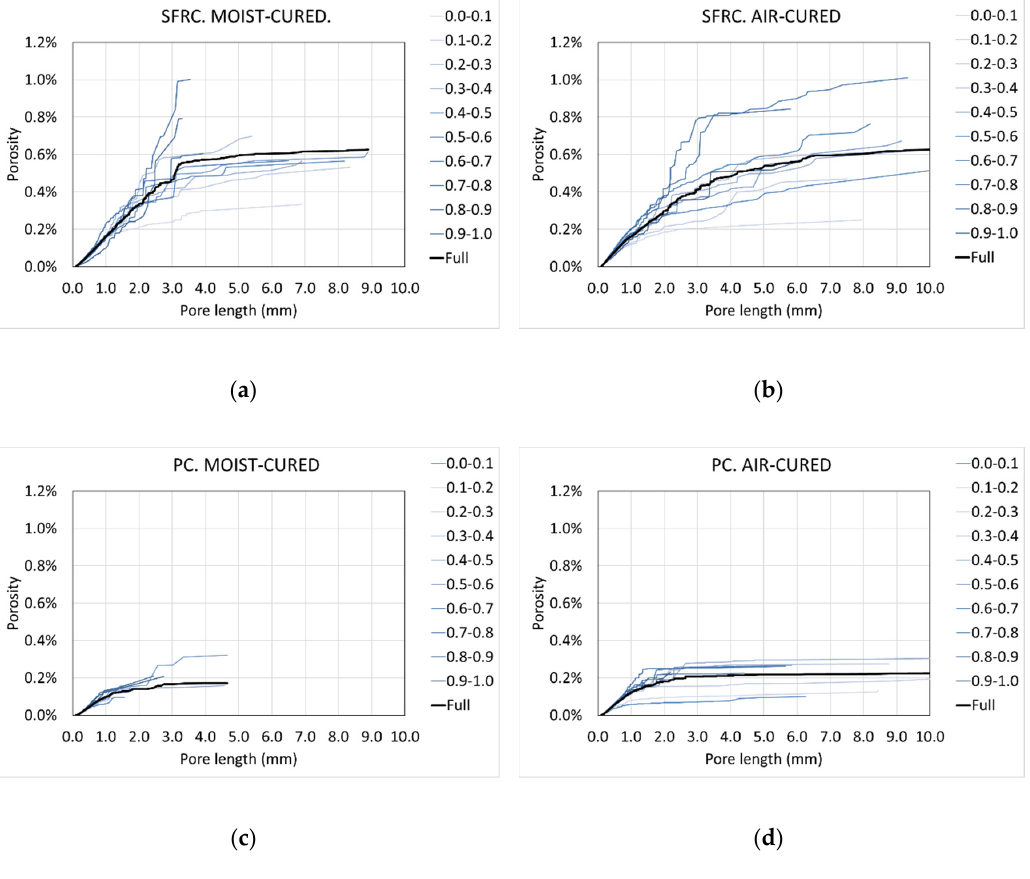
Figure 8. Porosity curves along the depth: ( a ) SFRC moist-cured, ( b ) SFRC air-cured, ( c ) PC moist-cured and ( d ) PC air-cured.